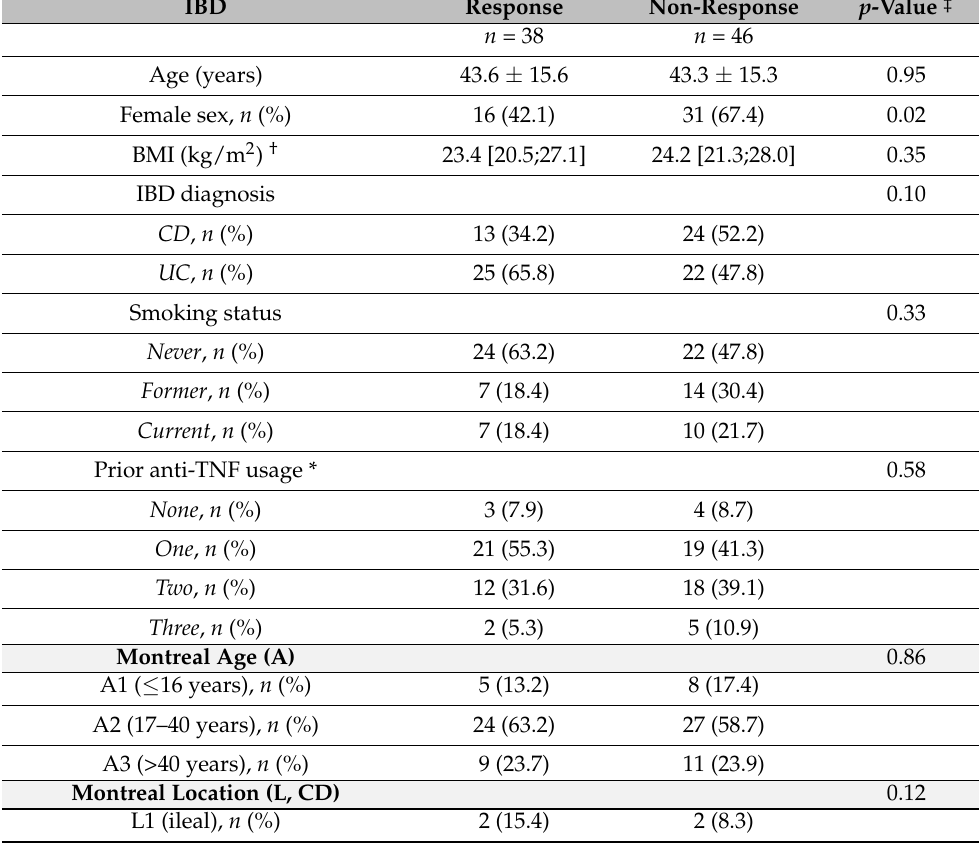
Table 1. Baseline cohort demographic and clinical characteristics of patients with IBD within the IBD